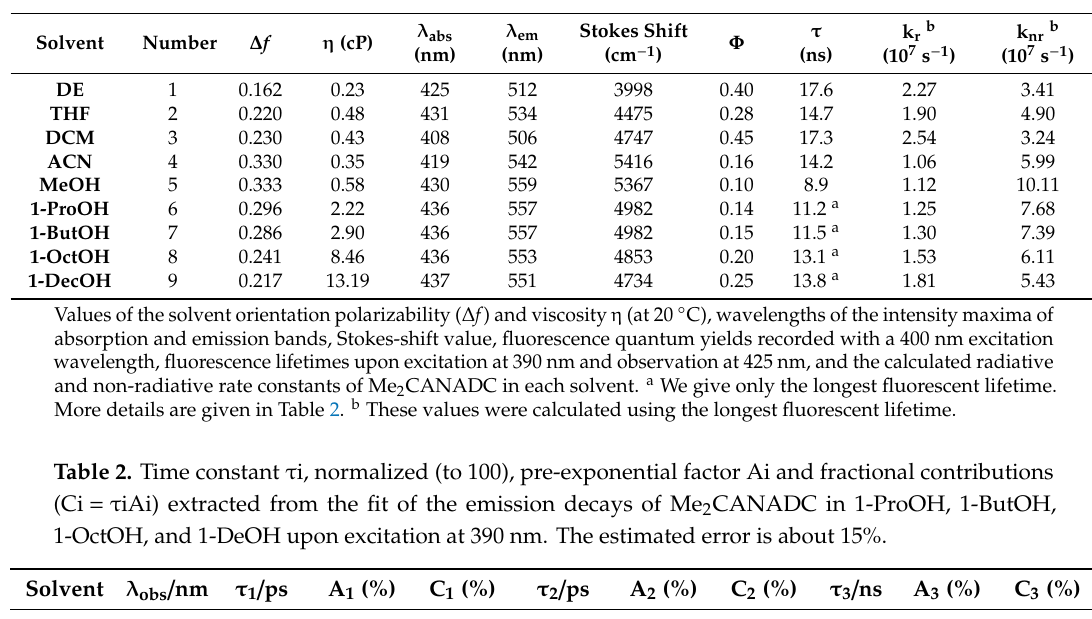
Table 1. Solvent properties and spectroscopic data of Me 2 CANADC.